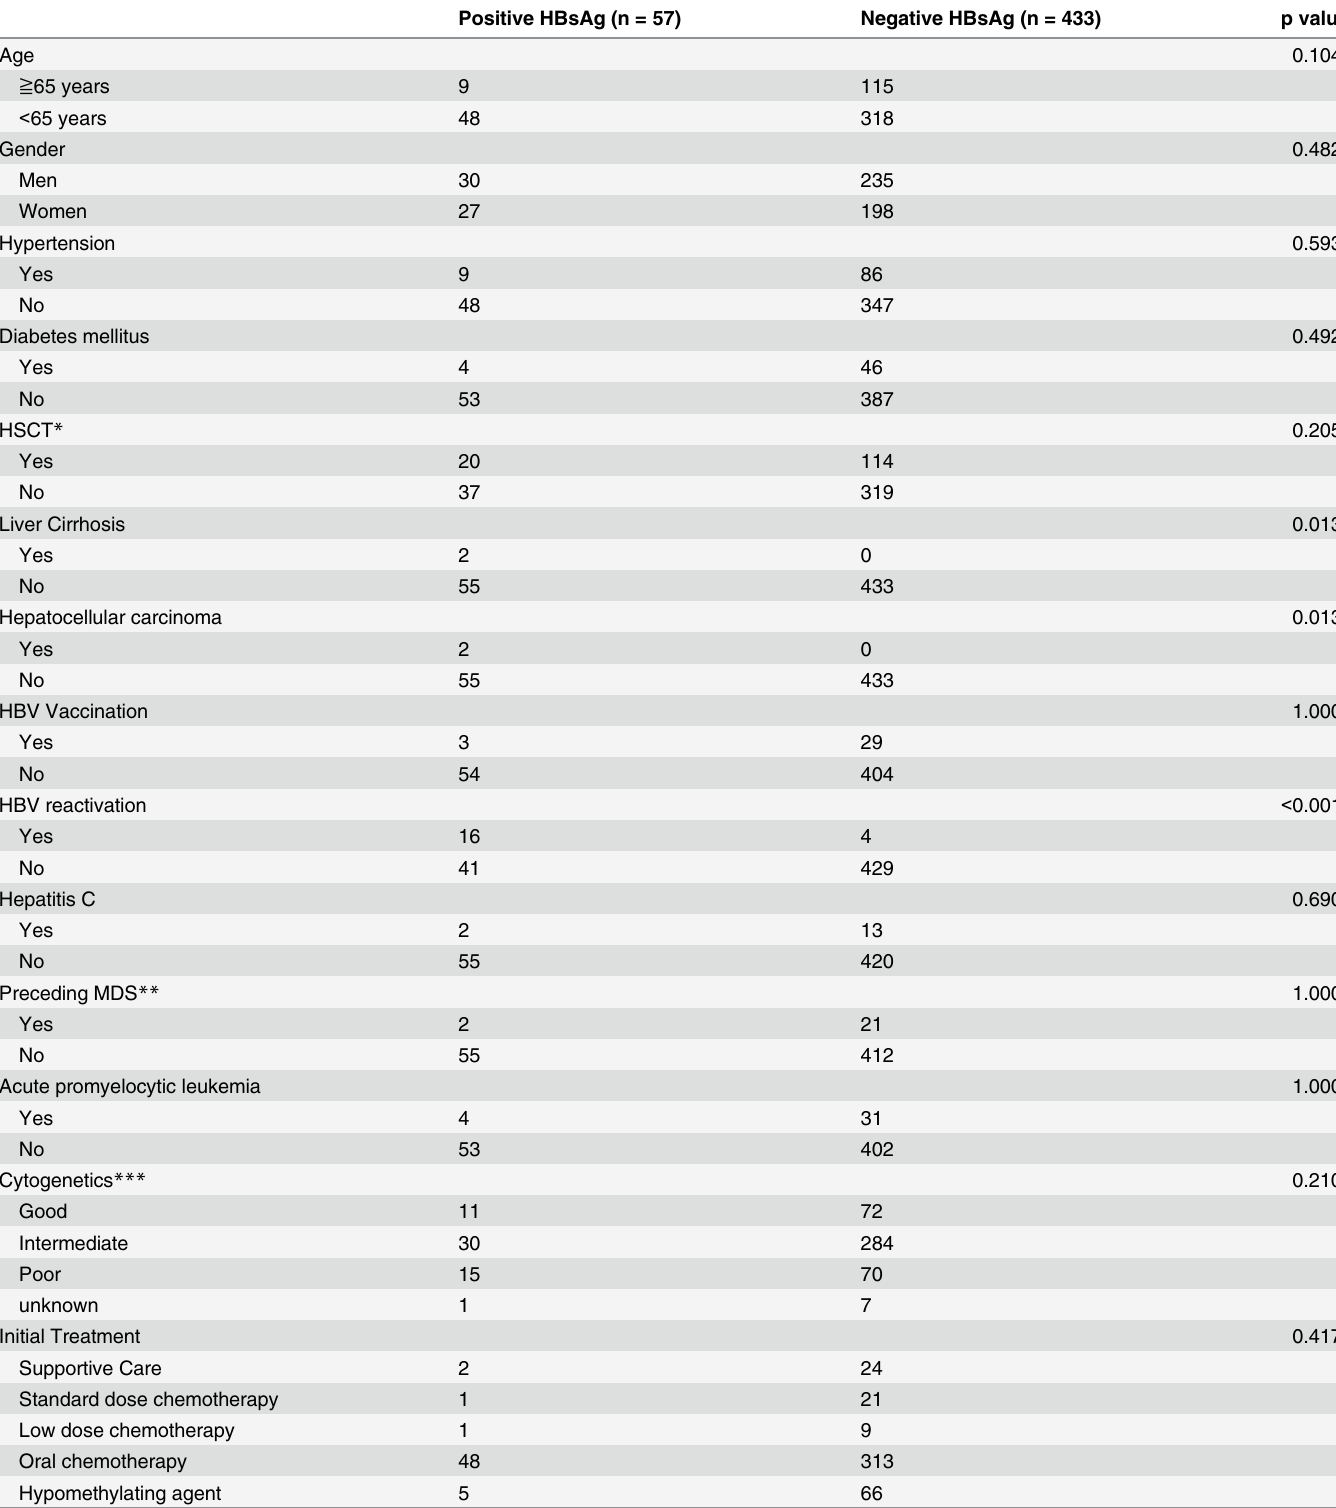
Table 1. Clinical characteristics of 490 acute myeloid leukemia patients with positive and negative hepatitis B surface antigen